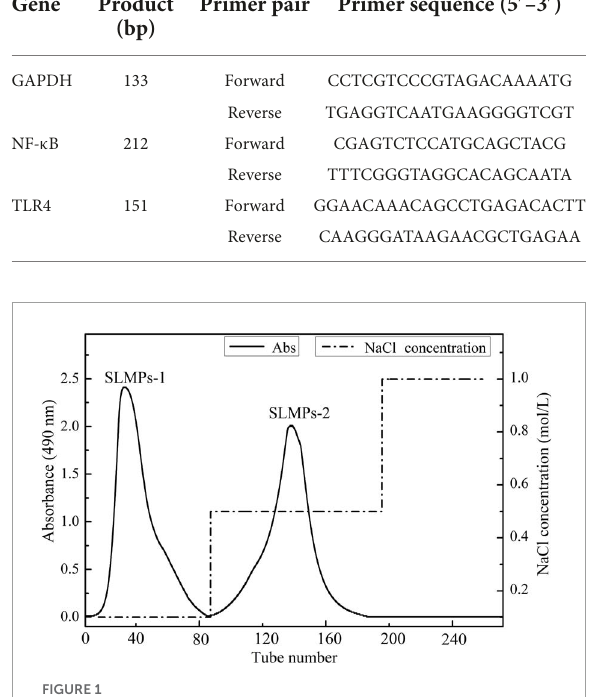
cellulose-52 anion exchange chromatographic column on with gradient elution of 0–1.0 mol/L NaCl; These two fractions were collected, dialyzed, concentrated, freeze-dried, and loaded onto Sephadex G-100 gel filtration chromatographic column for further purification, respectively. As shown in Figure 2 , each fraction generated only one single elution peak, representing SLMPs-1-1 and SLMPs-2-1, with yields of 61.4 and 54.9%, respectively. There is also a difference in the order of the collection tubes of SLMPs-1-1 and SLMPs-2-1, indicating that these two fractions are not only relatively pure single polymers, but also have different molecular